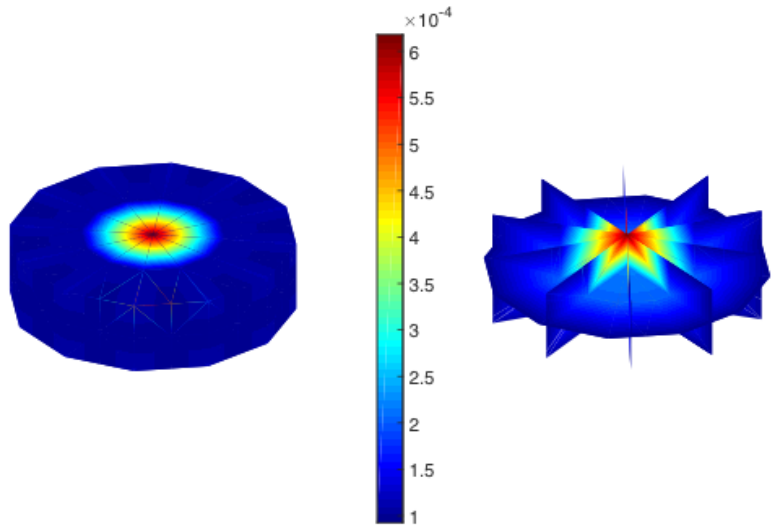
Figure 2. Single-crystal property matrix ( p 11 ) values in Rodrigues space for the compliance parameter S 11